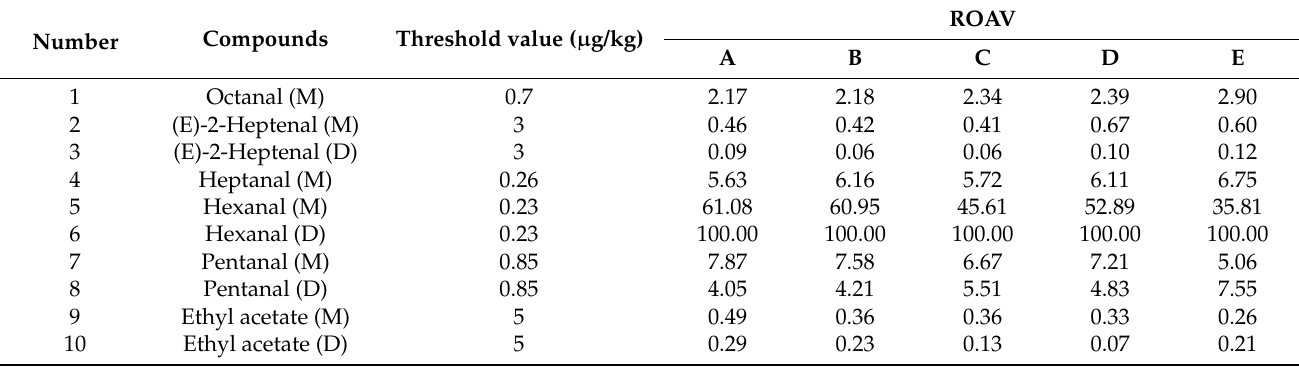
Table 2. ROAV of VOCs in walnut oil from five different varieties.